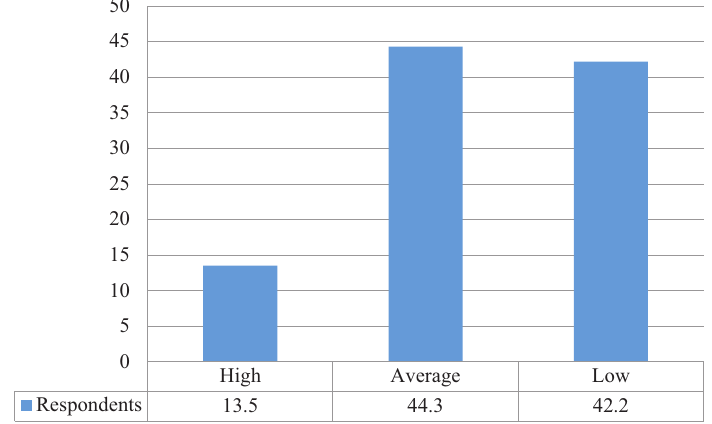
Figure 1. Quantitative indicators of the level of development of attention according to the method “Find and Cross